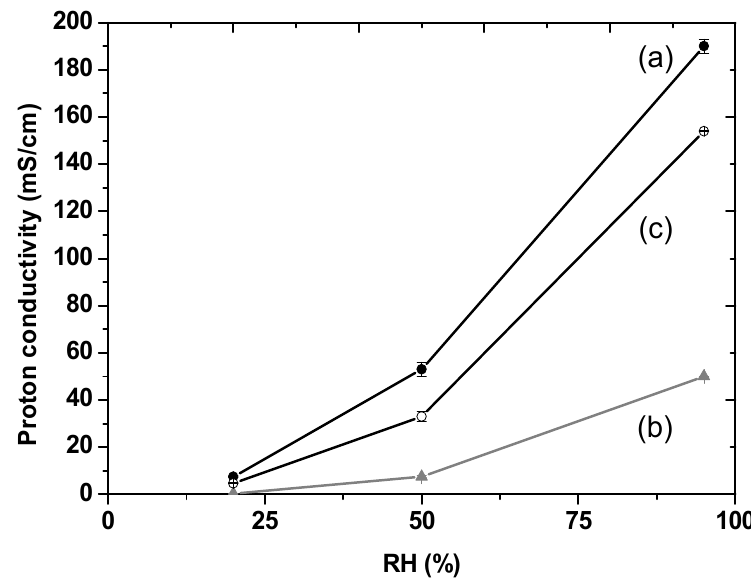
Figure 6. Proton conductivity measurements at 90 °C at different RH of pristine Aquivion ® membrane (a), composite membrane with 10 wt% loading of HNT (b) and 10 wt% loading of HNT-NH 2 (c).